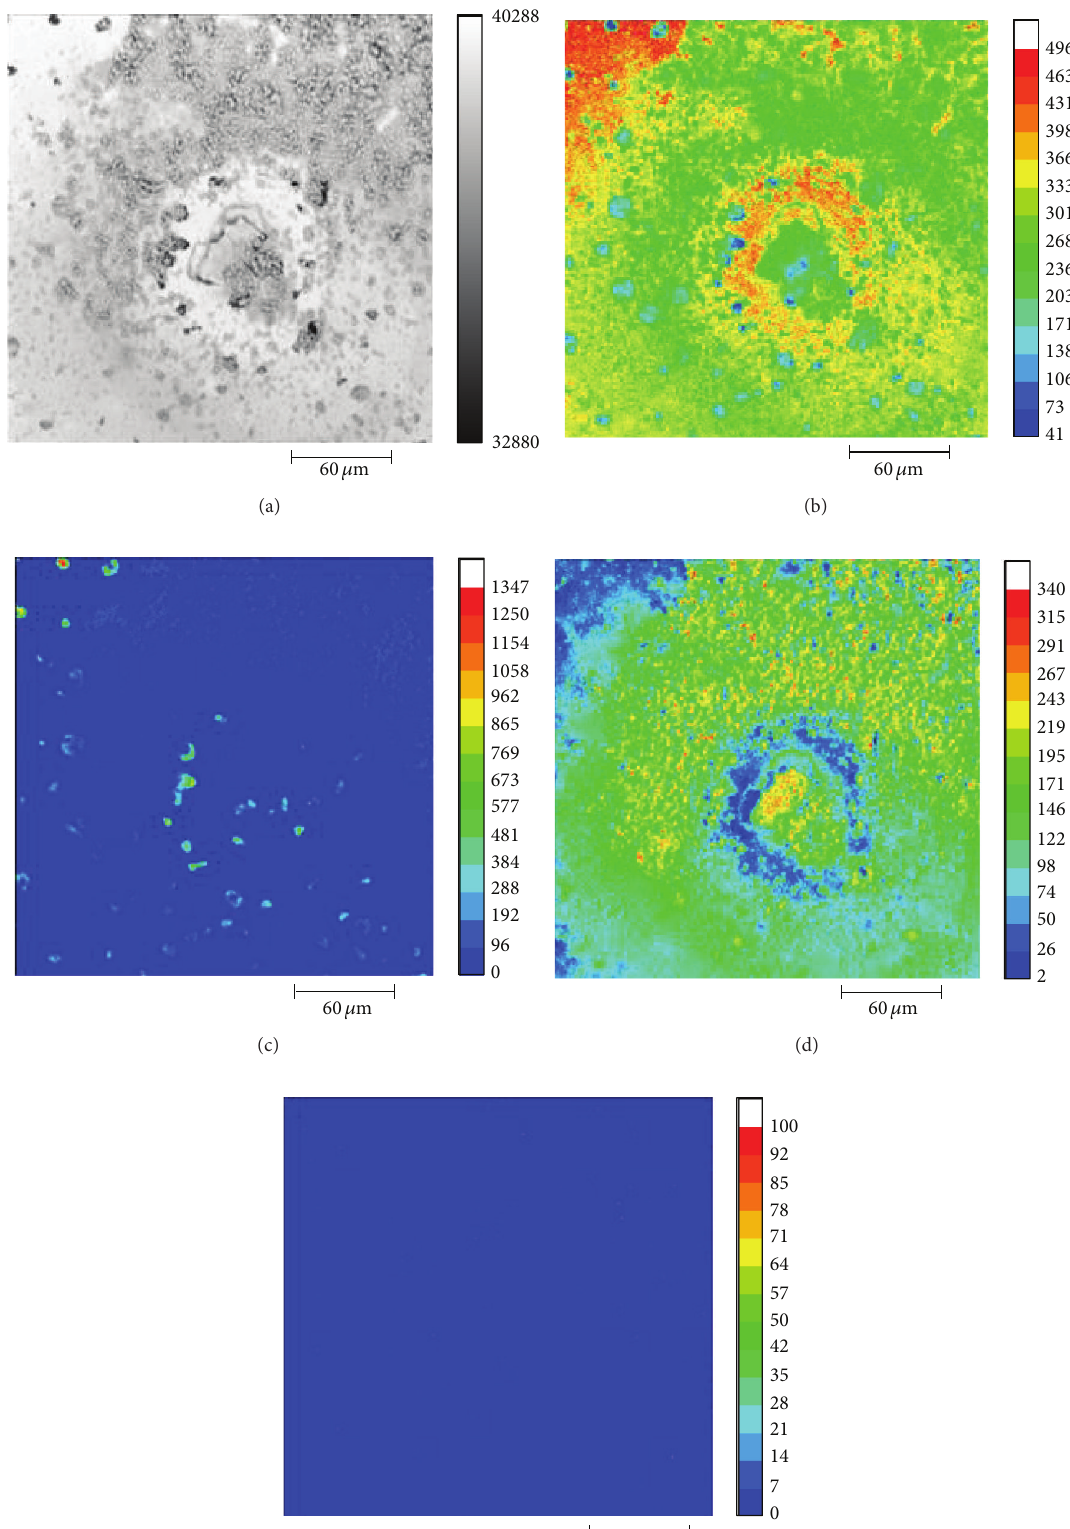
Figure 11: Elemental distribution analyzed by EPMA on the surface of ductile cast iron corroded in simulated cooling water (10,000 ppm NaNO 2 ) at 25 ∘ C for 72 hours; (a) SEM image, (b) Fe, (c) C, (d) O, and (e)